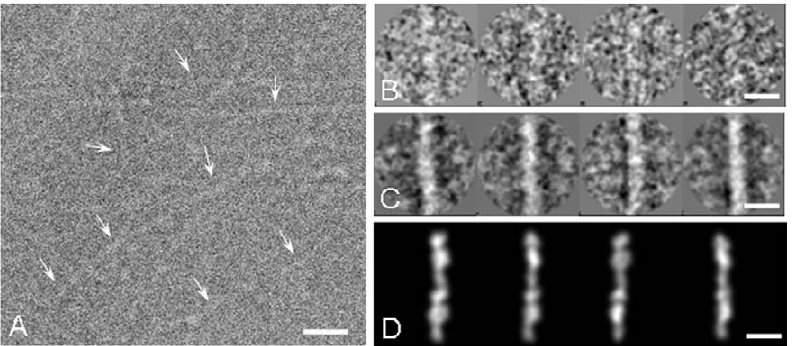
Figure 1. Negative stain EM of purified S.pneumoniae pili. (A) The micrograph shows a network of elongated thin structures indicated by white arrows. (B) Set of raw images of purified S. pneumoniae pili. (C) Representative class averages of purified S. pneumoniae pili segments. (D) Re- projection of the 3D reconstruction of the pilus. Scale bar in panel A 20 nm, scale bar in panels B, C and D 10 nm.